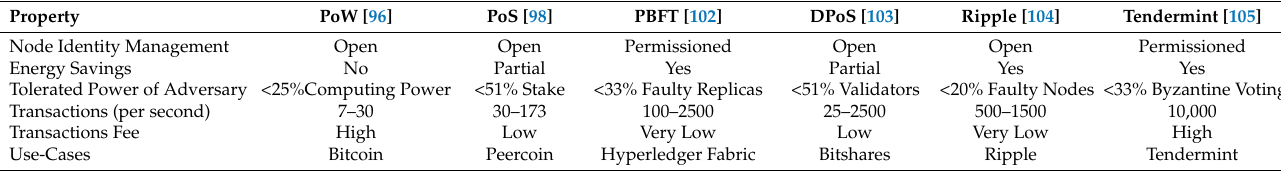
Table 2. Summarised Consensus Algorithms for